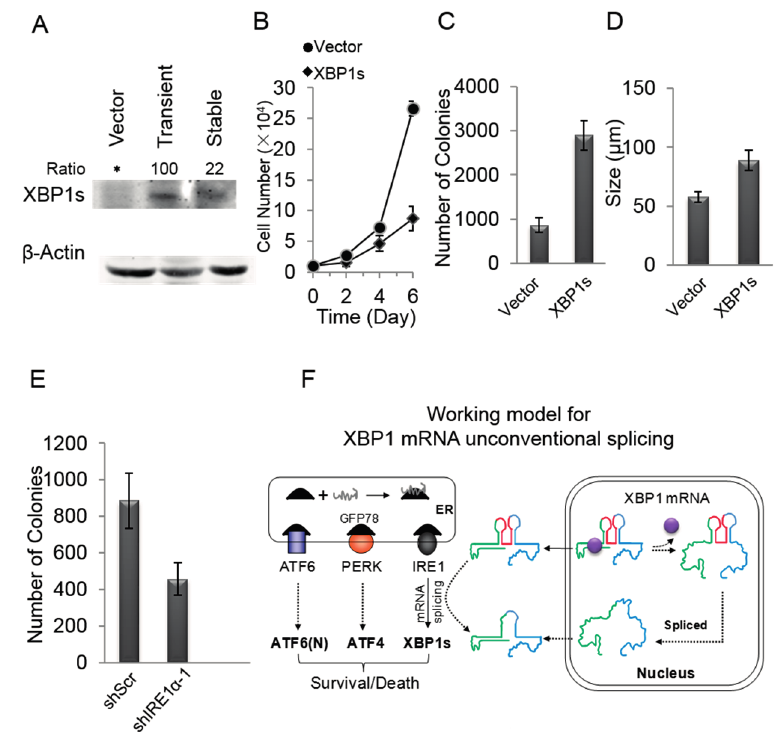
Figure 6. A low level of XBP1s promoted the growth of MCF-7 cells. ( A ) MCF-7 cells were infected lentivirus expressing XBP1s or empty vector. Cells in Passage 1 (transient) expressed a high level of XBP1s, while the adapted cells (stable) after Passage 1 expressed a low level of XBP1s, * means there was no stripe; ( B ) The growth rate of MCF-7/Vector and adapted MCF-7/XBP1s cells. Data are from three independent triplicate experiments. Error bars show means ± SD; ( C , D ) The soft agar colonies formation of MCF-7/Vecotr and adapted MCF-7/XBP1s cells. The colony numbers ( C ) and sizes ( D ) are shown. Data are from three independent triplicate experiments. Error bars show means ± SD; ( E ) The colony number of MCF-7/shScr and MCF-7/shIRE1 α -1 cells. shScr is the scramble sequence. shIRE1 α -1 is the knockdown sequences of IRE1 α , as verified in Figure 2A. Data are from three independent triplicate experiments. Error bars show means ± SD; and ( F ) Working model for XBP1 mRNA unconventional splicing. XBP1 mRNA is exported into the cytoplasm and undergoes acute ER stress-dependent splicing, but XBP1 mRNA also can be subjected to ER stress-independent splicing in the nucleus depends on its structure. Green and blue lines, respectively, present the 5 ′ - and 3 ′ -nucleotides of XBP1 mRNA. Red line represents the 26 nt intron. Purple ball represents RNA-binding protein that could regulate the structure of XBP1 mRNA for the nuclear unconventional